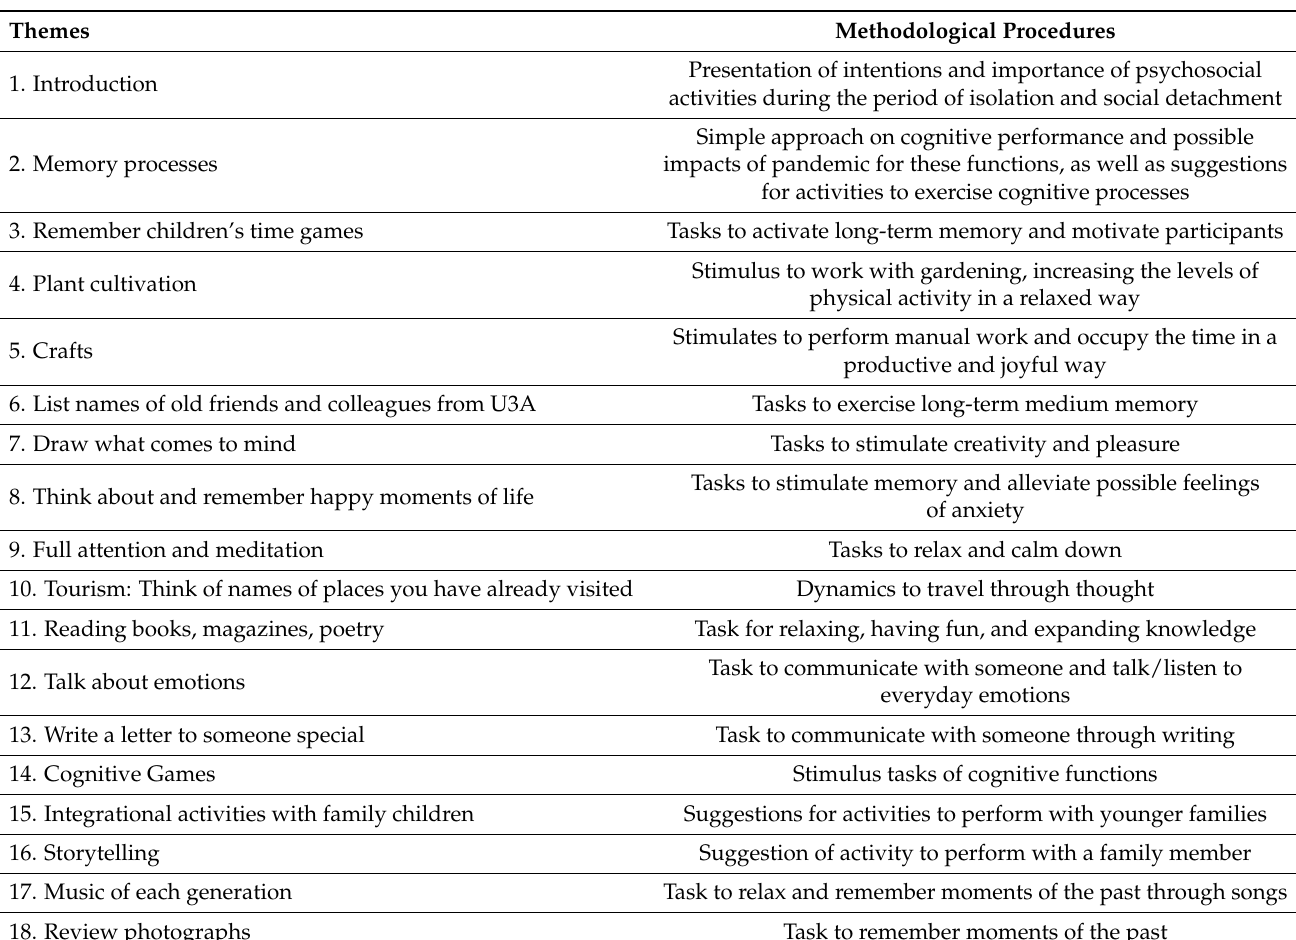
Table 2. Set of psychosocial activities offered by the “U3A in Motion” program